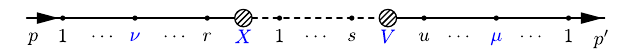
Fig. 9 Typicaldiagramcontributingto K photoninsertionswithvertex μ fixedatanarbitrarylocationonthefinalfermion(solid)lineandvertex ν on the initial fermion (solid) line. Notice that the momentum k of the inserted photon flows through the entire scalar (dashed)